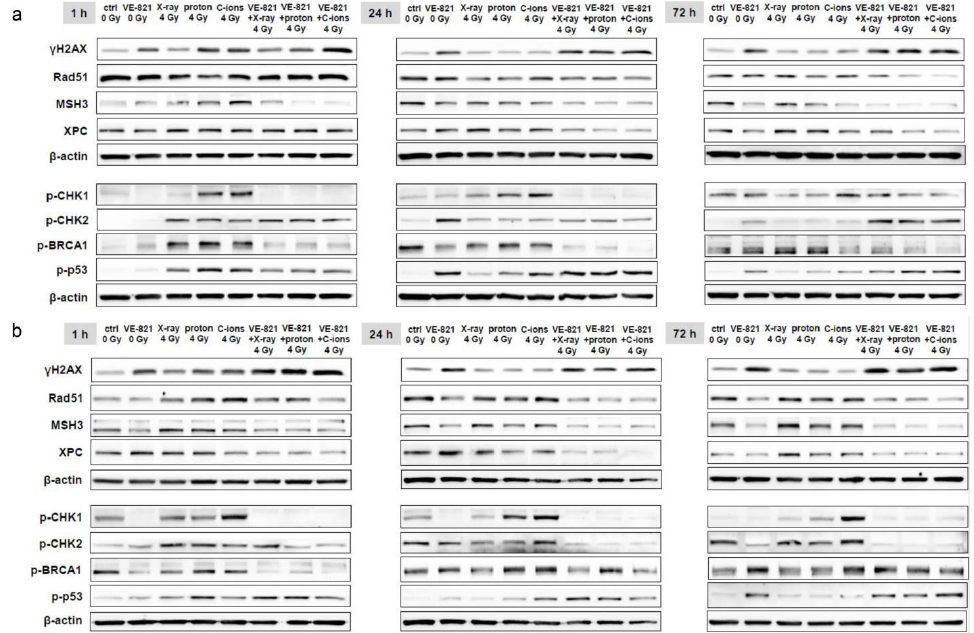
Figure 6. Protein phosphorylation pattern of DNA repair key players. The influence of the combined treatment with 10 µM VE-821 and 4 Gy X-ray/proton/C-ions IR on protein expression and phosphorylation of the DNA damage marker γH2AX, and of the DNA repair key players Rad51, MSH3, XPC, p-CHK1, p-CHK2, p-BRCA, and p-p53 were evaluated in ( a ) SW-1353 and ( b ) Cal78 cells by immunoblotting under non-IR control conditions (ctrl) after 1 h, 24 h, and 72 h. β -actin was used as loading control. Changes were presented as fold change ( ∆ -ratio) normalized to non-IR controls (mean ± SD of n = 3) (see Tables S5 and S6).